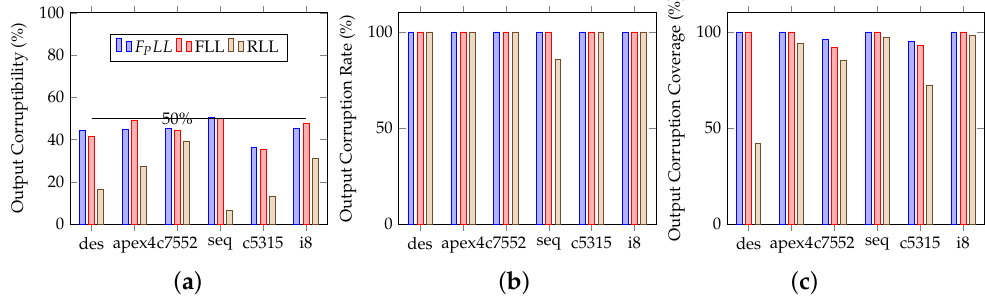
Figure 10. Output corruption evaluation of F P LL and comparison with FLL and RLL (benchmarks are in decreasing size order): ( a ) uutput corruptibility, ( b ) output corruption rate, ( c ) output corrup- tion coverage.